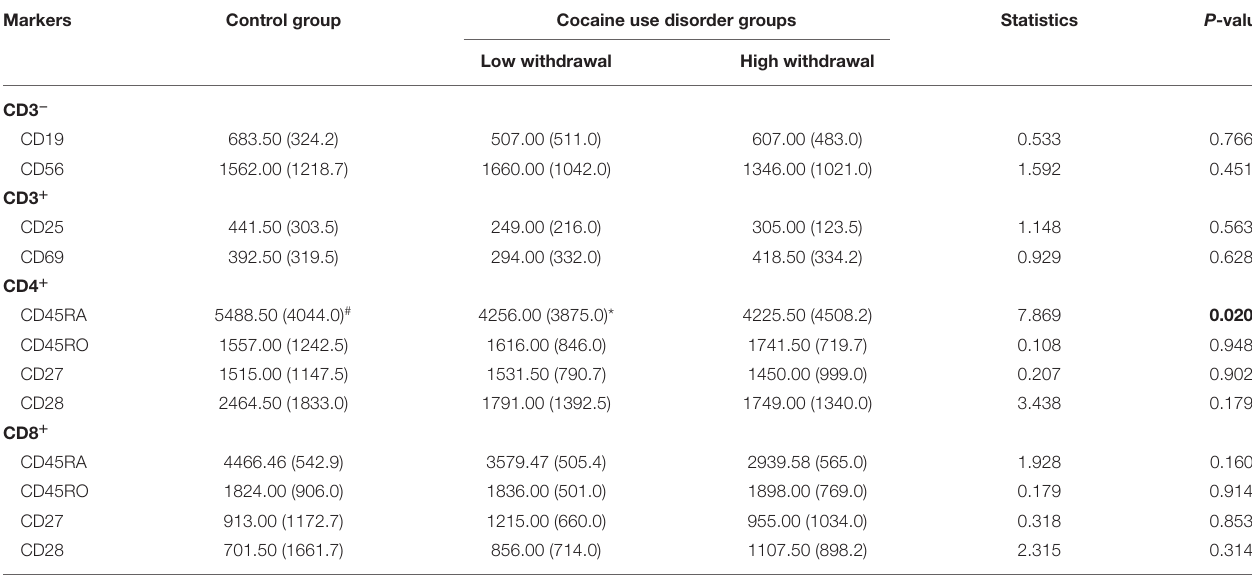
TABLE 3 | Mean fluorescence intensity (MFI) of activated and regulatory markers.